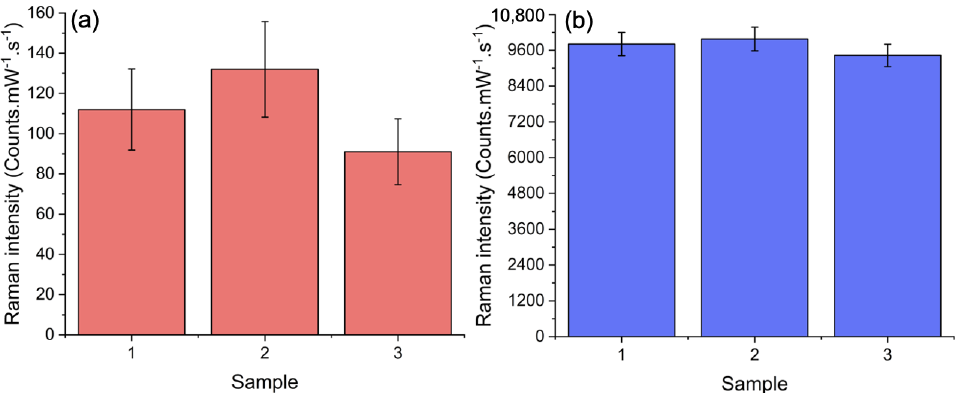
Figure 4. Raman intensity (SERS + PIERS) of the 1073 cm − 1 peak for three samples whose the average RSD is <20% for the following thiophenol concentration (for UV-irradiation of 30 min): ( a ) 100 pM, and ( b ) 1